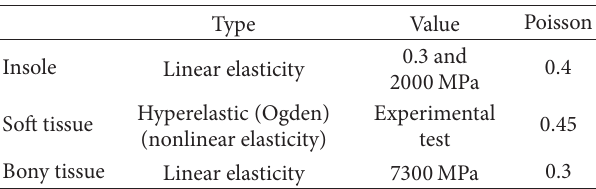
Table 1: Mechanical properties of bony and soft tissue and insole [11, 13, 14].